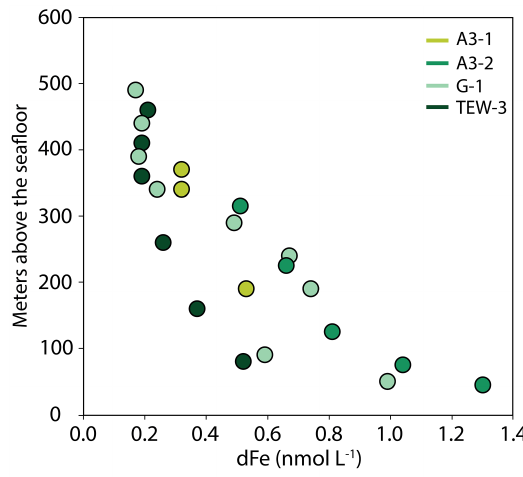
Figure 7. Dissolved Fe concentrations as a function of height above seafloor for all the stations of cluster 2. Bottom depths are taken from the CTD data. The same colour code as used in Fig. 1 applies